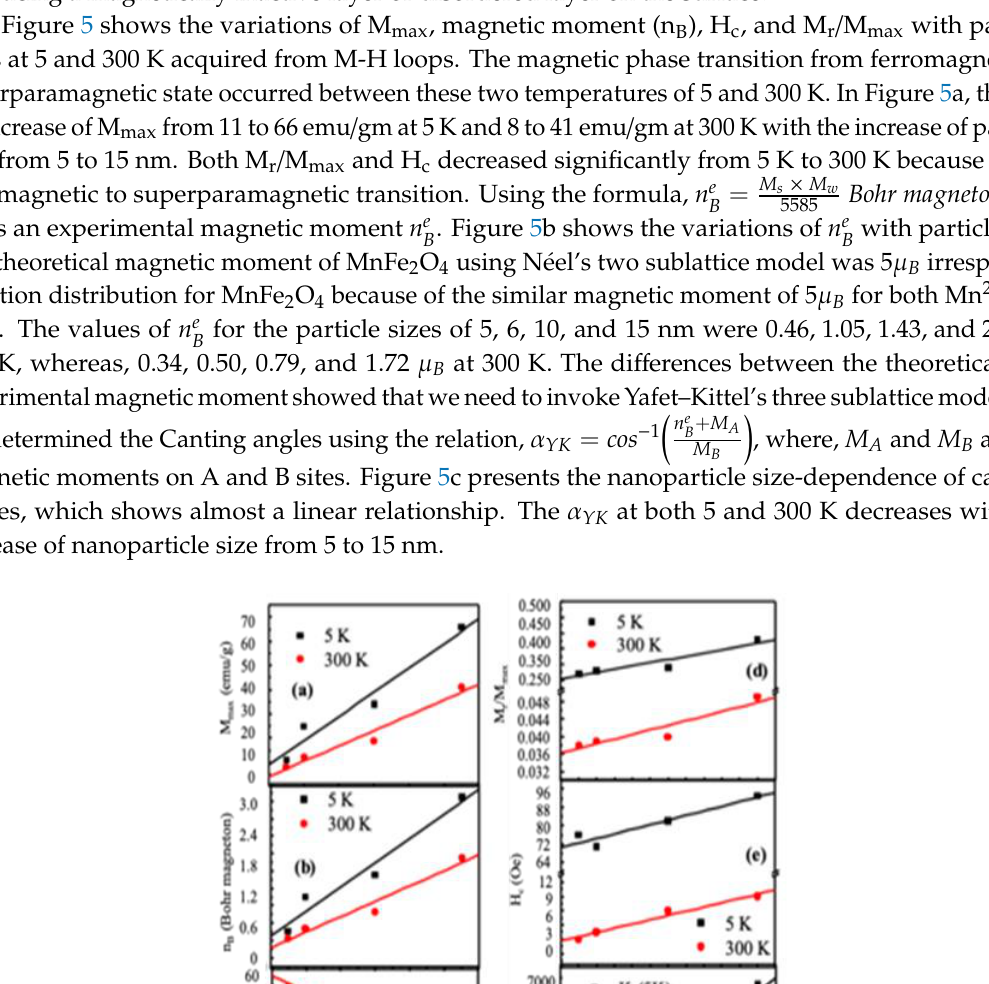
Figure 4. M-H hysteresis loops of MnFe 2 O 4 nanoparticles in the as-dried condition measured at 5 and 300 K with a maximum applied field of 5 Tesla. The M-H loops of the MnFe 2 O 4 nanoparticles at different pH are presented, ( a ) 5 nm, ( b ) 6 nm, ( c ) 10 nm, and ( d ) 15 nm.